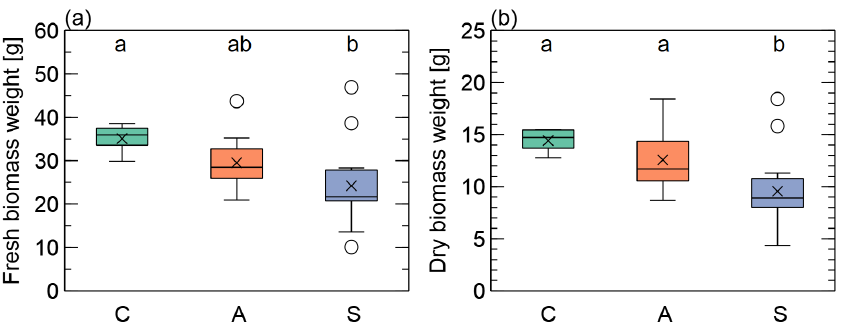
Figure 9. Fresh and dry biomass of Scots pine seedlings. Two studied variants of mixing with ash ( a ) and sewage sludge ( b ) are shown.Three types of treatments were used: Soil amendments with phosphogypsum mixed with organic ash–A, sewage sludge–S and control–C. The small Latin letters above the boxplots, when the same, indicate that there is no statistically significant difference between the groups in p < 0.05. In the plot, boxes span from 1st to 3rd quantile, with the median indicated by a line, whiskers indicating 1.5 inter-quantile range, the × symbol mean value, and circles outlier